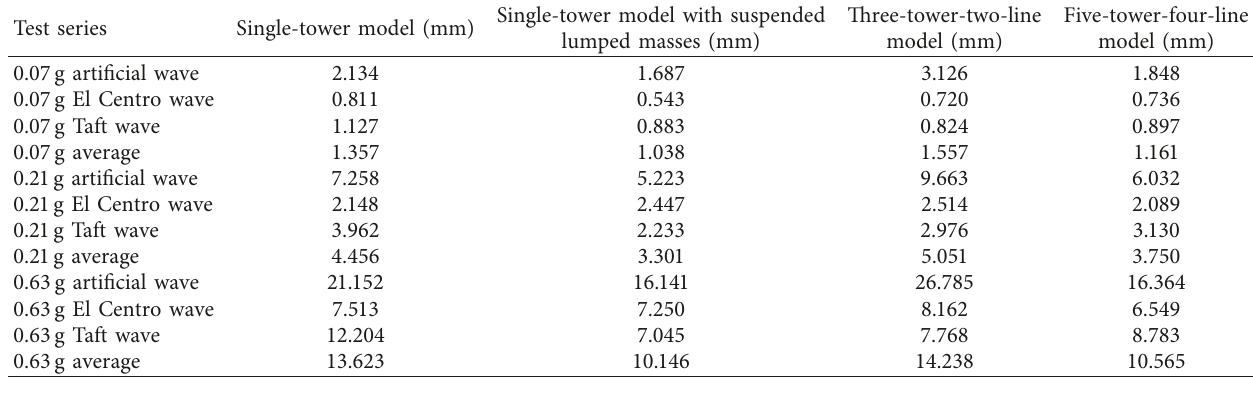
Figure 25: Transverse peak displacement responses of the four models under a 0.21g artificial wave. Table 8: Transverse peak displacement responses of the middle towers of the four models.